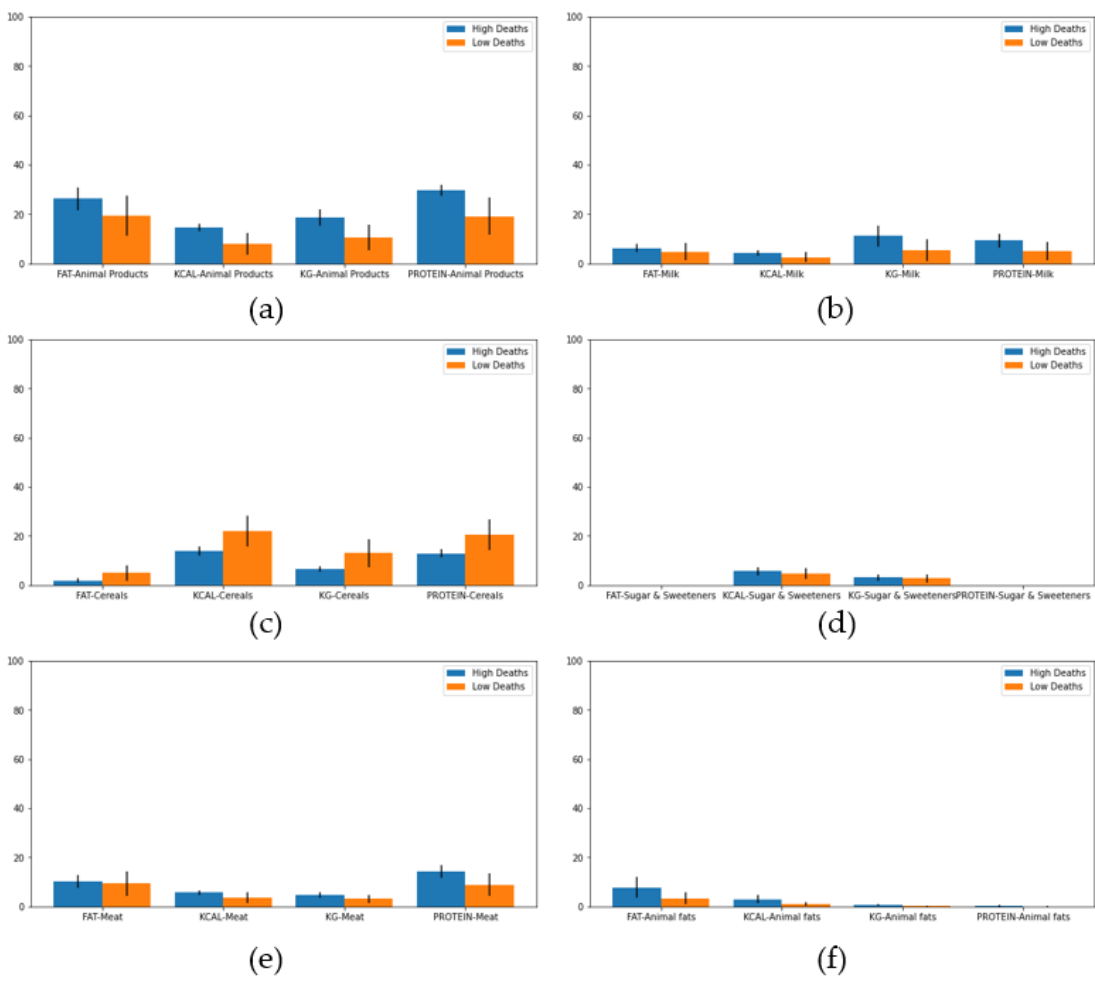
Figure 4. Mean percentage and standard deviation of consumption for different food in high and low death clusters. ( a ) Animal products, ( b ) Milk, ( c ) Cereals, ( d ) Sugar and Sweeteners, ( e ) Meat, and ( f ) Animal fats.